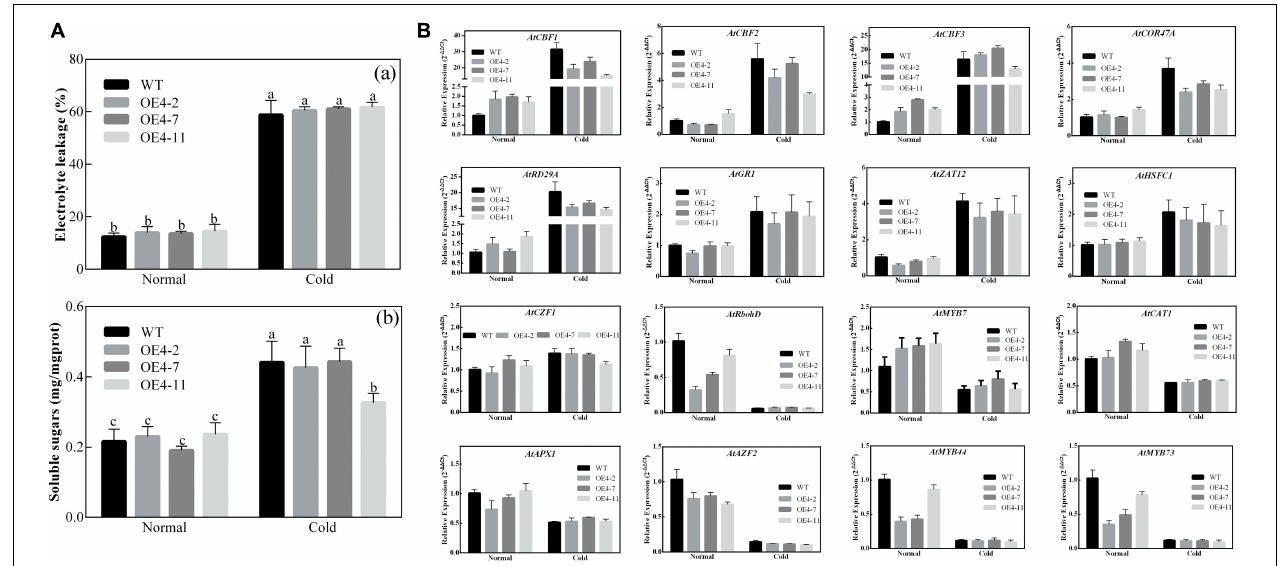
FIGURE 6 | Analysis of EL, TSS contents and cold-related genes transcripts in CsPMEI4 -OE lines and WT plants. (A) EL and TSS contents of CsPMEI4 -OE lines and WT plants under different temperature conditions. (a) Electrolyte leakage, EL; (b) total soluble sugar content. Data are shown as the means ± SE ( n = 3). (B) Expression analysis of cold-related genes in CsPMEI4 -OE lines and WT plants under cold condition. The final results were calculated with 2 - (cid:49) (cid:49) Ct method. Data are shown as the means ± SE ( n =